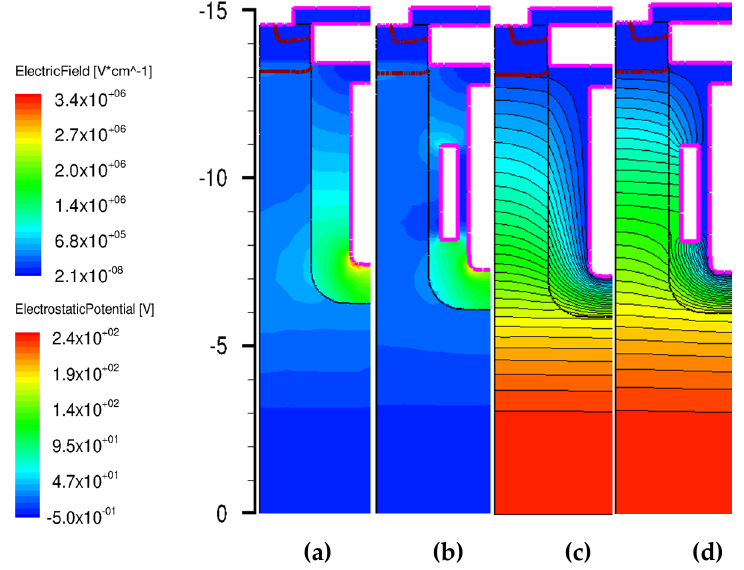
Figure 2. Electric field distribution of ( a ) SGRSO and ( b ) DFSGRSO UMOSFETs and potential distribution of ( c ) SGRSO and ( d ) DFSGRSO UMOSFETs.